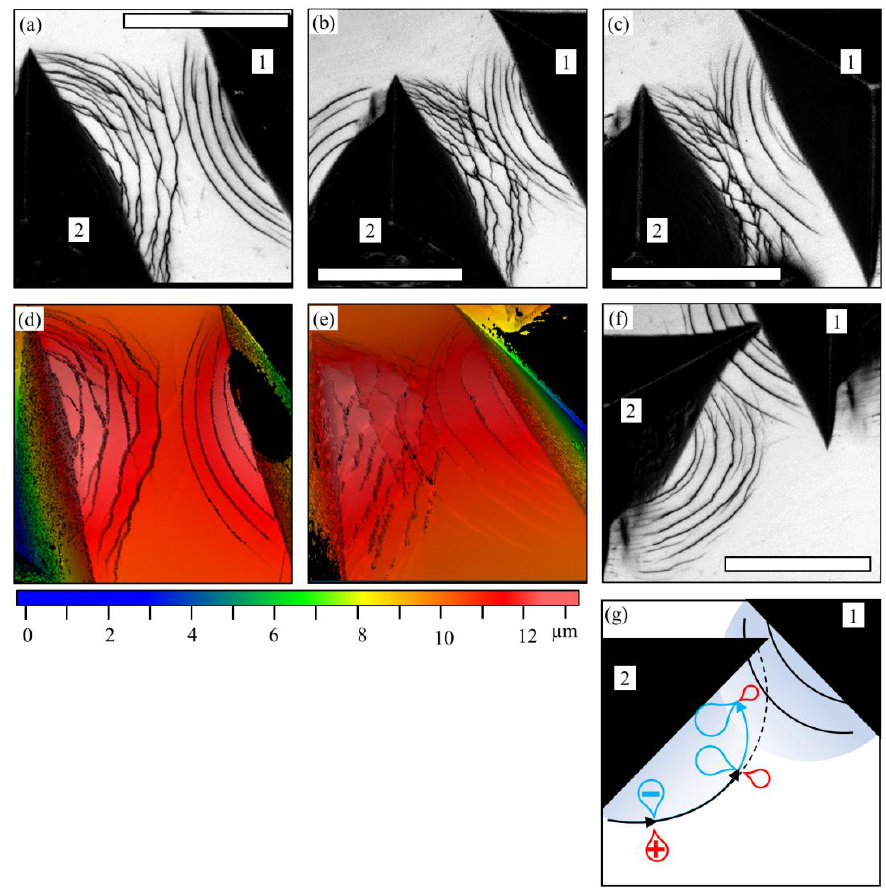
Figure 5. The topology of the surface in the vicinity of the indenter footprint reflecting the different behaviour of shear bands (SBs) formed by the indentation of the polished surface of the Zr-based bulk metallic glass (BMG). The optical images ( a – d ) and 3D surface maps ( d ,e) were obtained with the scanning white-light interferometry (SWLI) technique. The shear bands form regular arc-shaped steps when indentation is performed on a “fresh” non-deformed surface (marked as “1” on ( a – c , f )). Indenting the area near the previous indents forms the shear bands deviated from arc-shape (marked as “2” on ( a – f) ). The scale bar refers to 50 µ m on ( a – c,f) . 3D surfaces of images on ( a ) and ( b ) are coloured according to the height magnitude ( d , e ). The schematics of SB deflection due to the stress field gradient observed in ( f ) is shown in the subfigure ( g